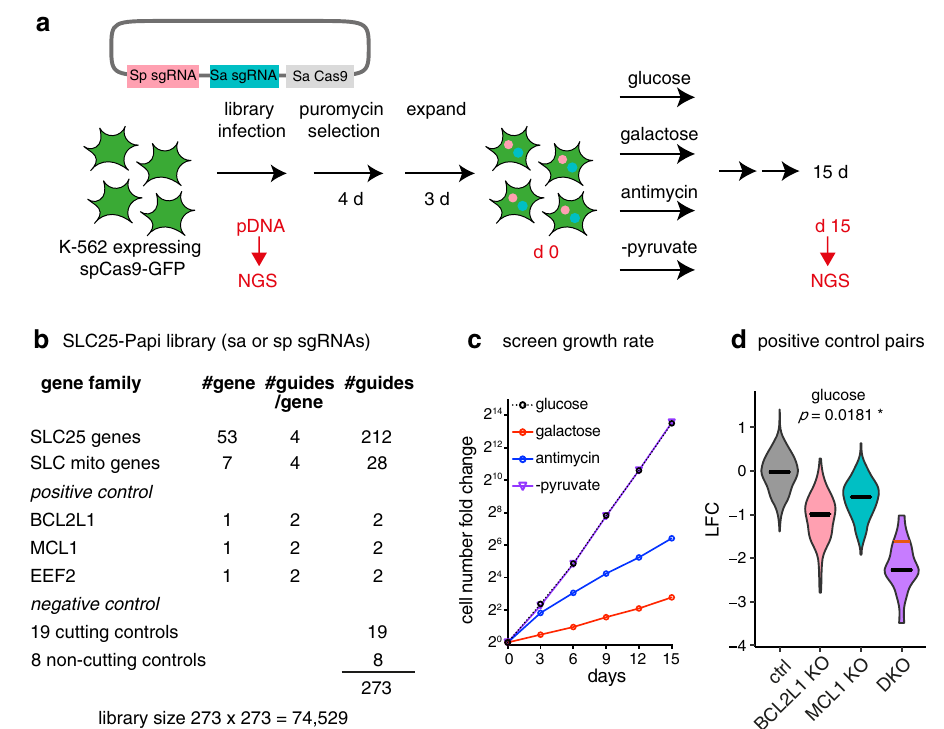
Fig. 1 Combinatorial CRISPR screen of the SLC25 family transporters across four media conditions. a Schematic overview of the combinatorial CRISPR strategy. b SLC25-Papi library construction. c Growth rate of the pooled CRISPR screen. The batch 2 growth rate was shown and representative of the two batches. d positive control pair BCL2L1 and MCL1. Data shown are log2 fold changes from day 15 in the glucose condition. Gray, control-control pair; pink, BCL2L1 x Ctrl or Ctrl x BCL2L1; blue, MCL1 x Ctrl or Ctrl x MCL1; and purple, the double knockouts of BCL2L1 x MCL1 or MCL1xBCL2L1. The black lines indicate the median and the red line indicates the expected value for the double knockout based on the sum of the single knockouts when there is